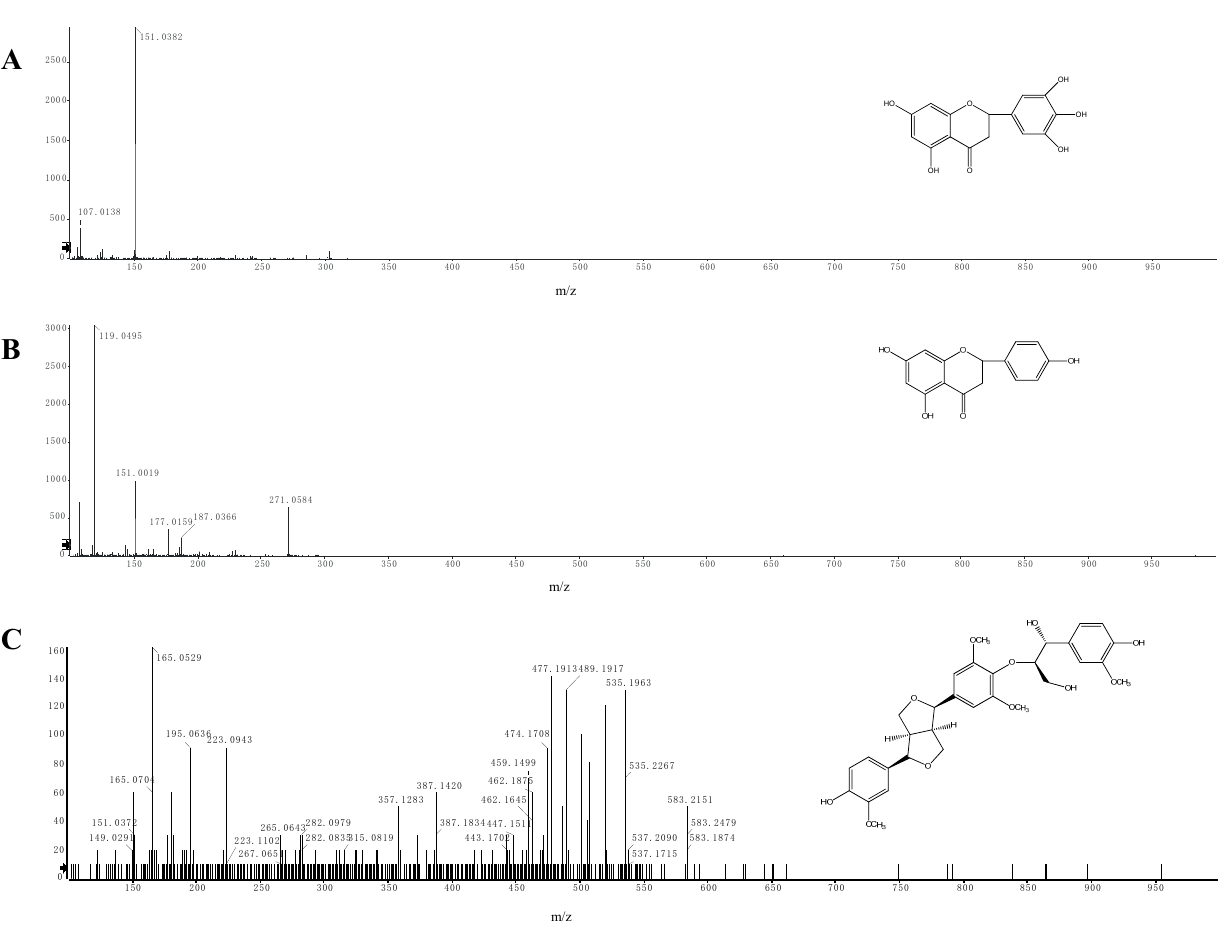
Figure 5. LC-ESI-MS/MS spectra of compounds in the phenolic extract. ( A ) 5,7-dihydroxy-2- (3,4,5-trihydroxyphenyl)chroman-4-one; ( B ) 5,7,4-trihydroxyflavanone; ( C ) buddlenol